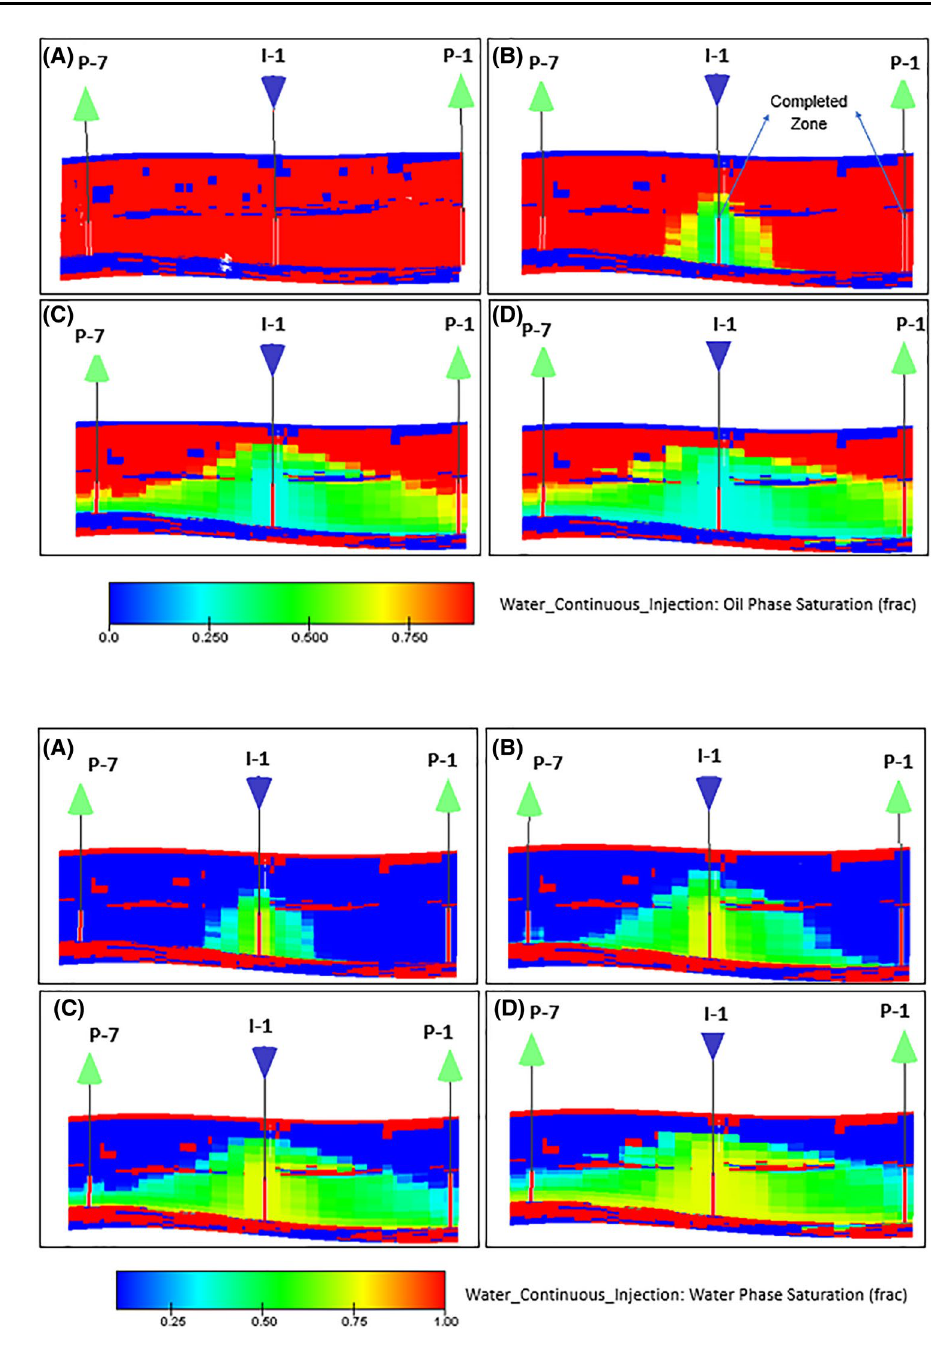
Fig. 8 Oil saturation on a plane intercepting the wells P-7, I-1 and P-1. a Starting oil satura- tion. b – d oil saturation after 6 months, 5 years and 10 years of production, respectively